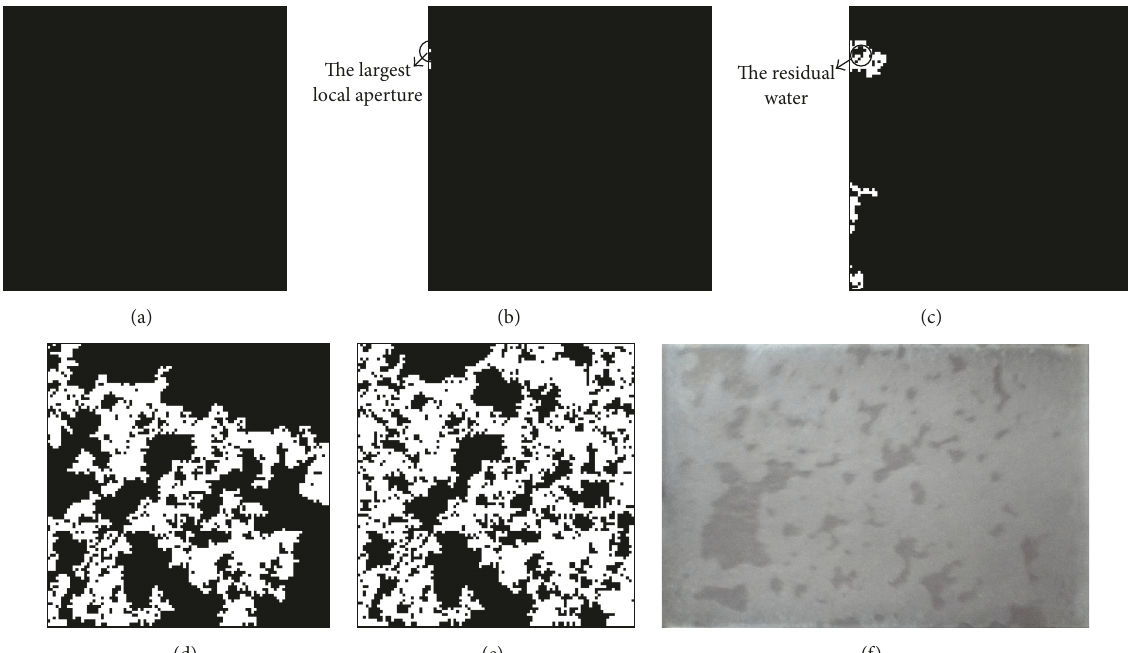
Figure 8: A sequence of the water saturation maps at different steps: (a) 𝑃 𝑐 = 0.15 kPa; (b) 𝑃 𝑐 = 0.22 kPa; (c) 𝑃 𝑐 = 0.27 kPa; (d) 𝑃 𝑐 = 0.33 kPa; (e) 𝑃 𝑐 = 0.38 kPa; (f) snapshot of the residual water of the